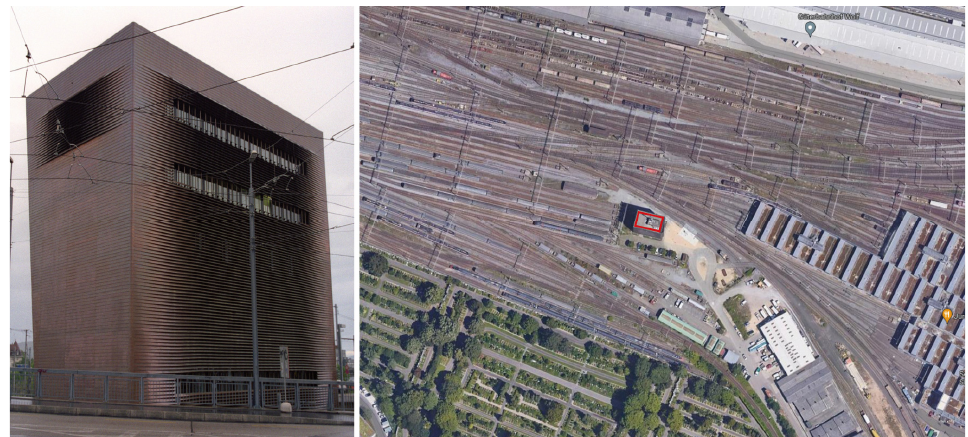
Figure 2. Research subject. Signal Box auf dem Wolf in Basel ( left ) [49] and master plan ( right )